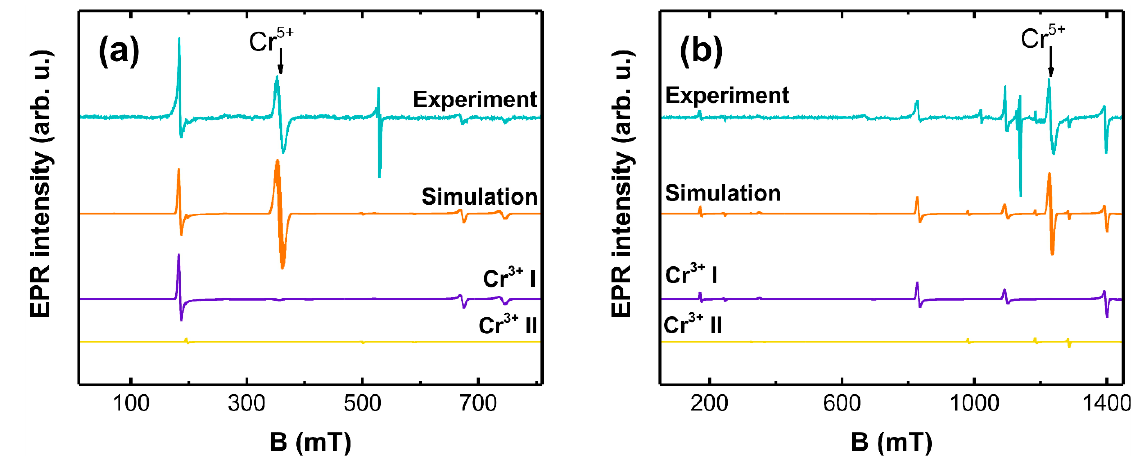
Figure 10. ( a ) X ‐ band and ( b ) Q ‐ band EPR spectra simulations of 0.1% Cr LaOCl sample after annealing at 800 °C in Figure 10. ( a ) X-band and ( b ) Q-band EPR spectra simulations of 0.1% Cr LaOCl sample after annealing at 800 ◦ C in reducing atmosphere. reducing